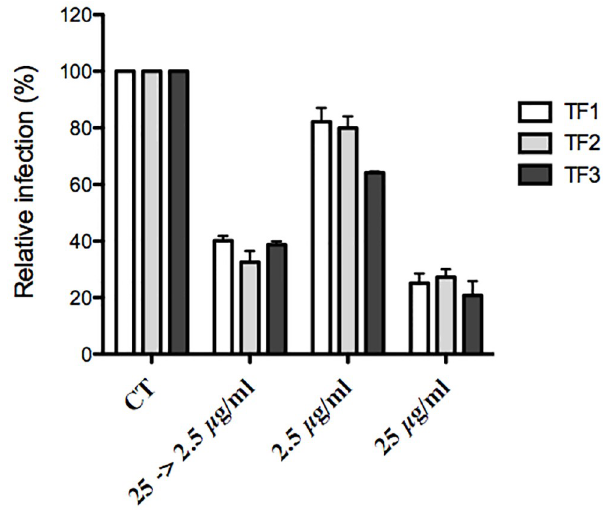
Fig 5. Theaflavins act on the viral particles prior inoculation. HCV virus stock was pre-incubated with 25 μ g/ml of theaflavins for 1 h before inoculation, and then the mixture was diluted 10 times before being used for the inoculation, leading to a final concentration of theaflavins of 2.5 μ g/ml (25 - > 2.5 μ g/ml). In parallel, Huh-7 cells were inoculated with HCV in the presence of theaflavins either at 2.5 or 25 μ g/ml. Cells were fixed and subjected to immunofluorescence to quantify infected cells as described above. Data are normalized to the DMSO, which is expressed as 100% infection. The results are presented as means ± SEM of three independent experiments performed in